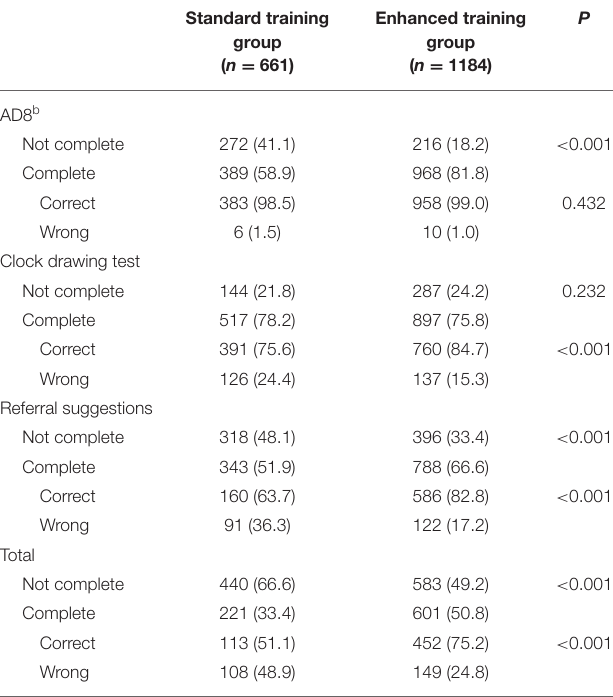
TABLE 3 | Comparison of the dementia detection skills between the standard and the enhanced training groups according to submitted records a